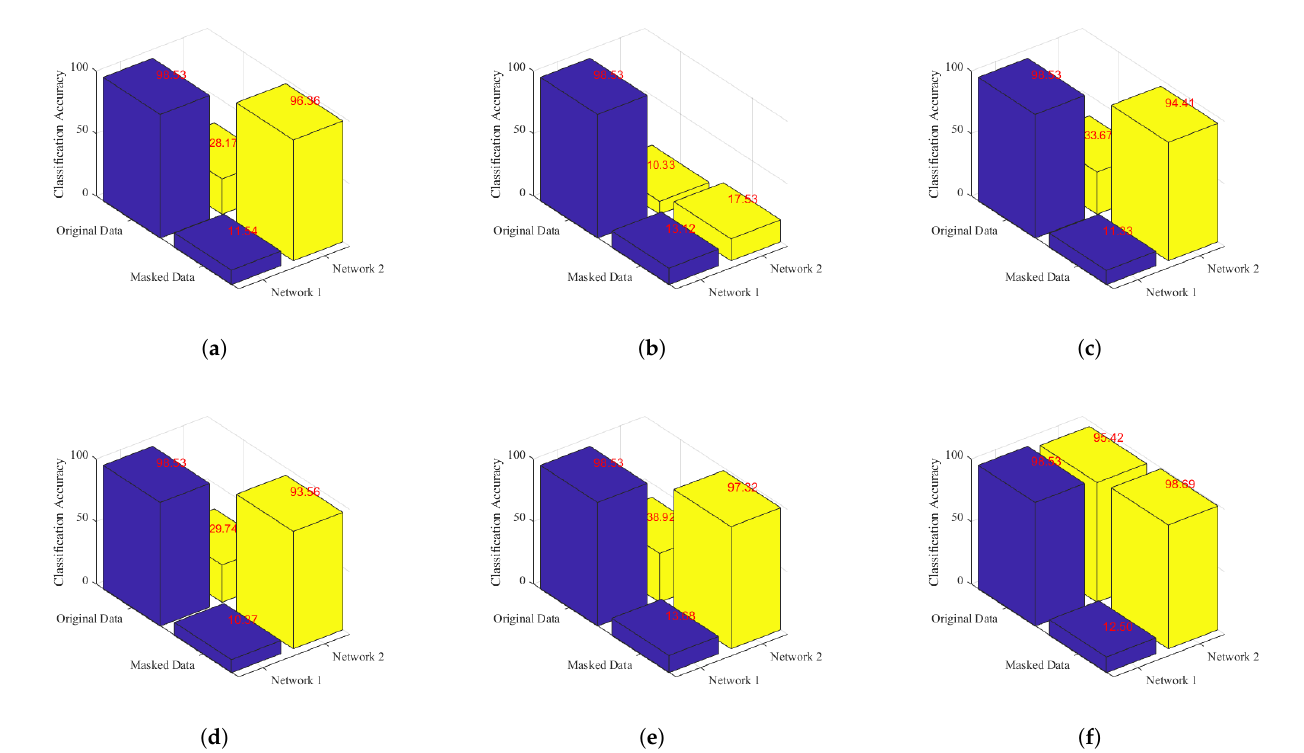
Figure 5. Comparison of classification accuracy for Network 1 trained with original data and Network 2 trained with masked data. ( a ) Ablation-CAM. ( b ) Score-CAM. ( c ) Grad-CAM. ( d ) Grad-CAM++. ( e ) XGrad-CAM. ( f ) Self-Matching